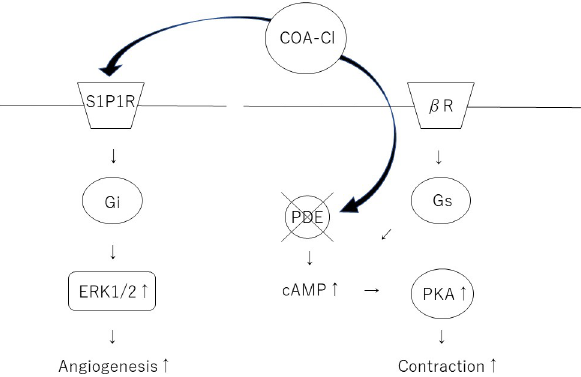
Fig 9. A schematic illustration showing the cascade of both angiogenesis and the positive inotropic effects.